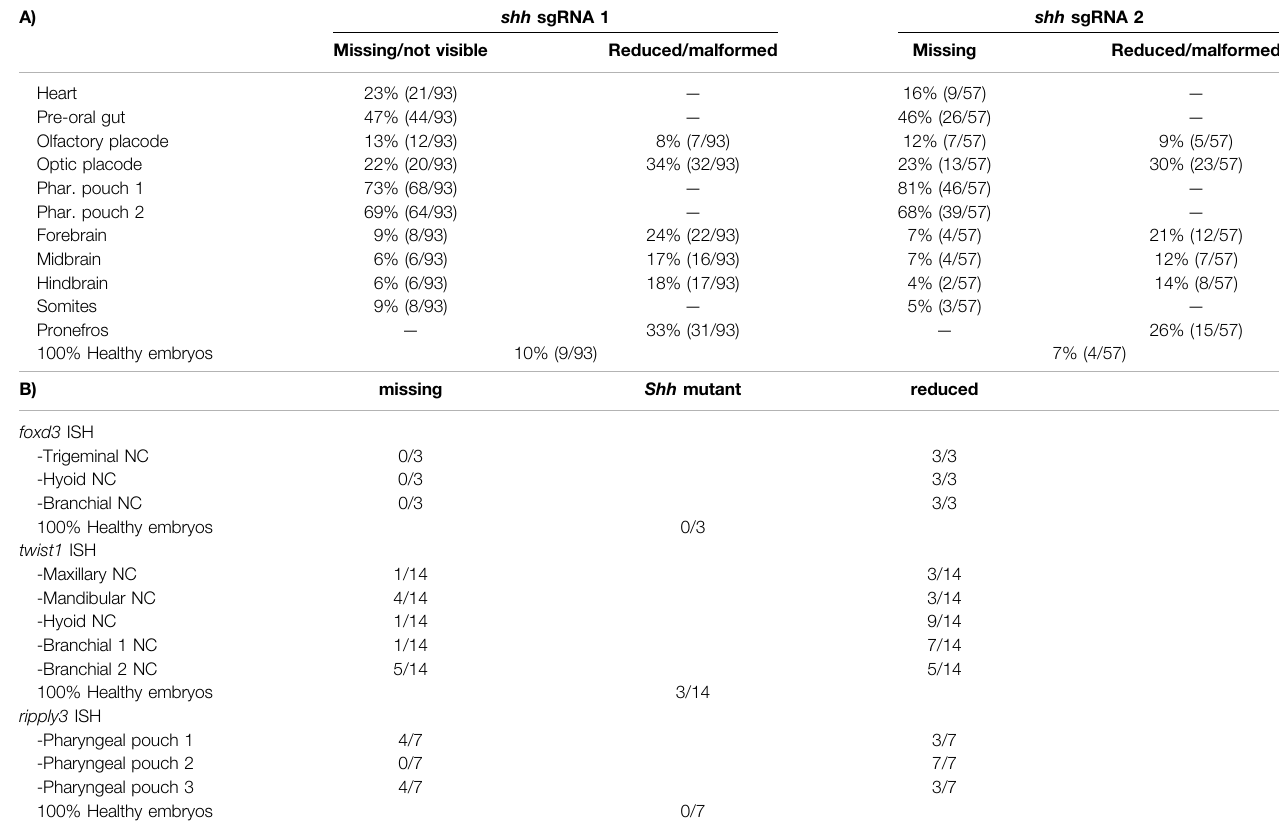
TABLE 3 | Summary of observed phenotypic effects of Δ shh sterlet embryos.